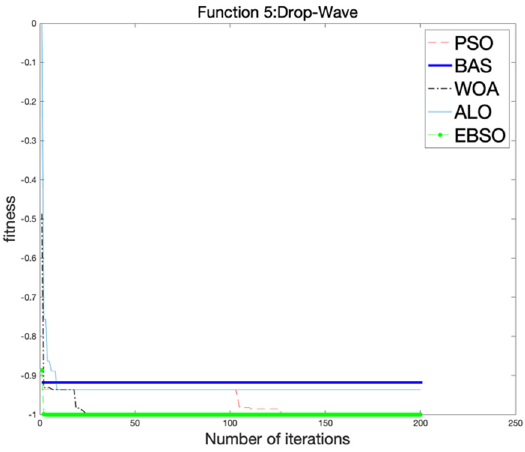
Figure 10. Iterative convergence graph.